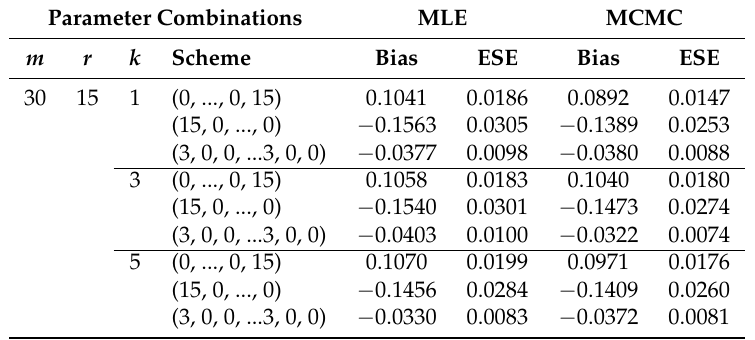
Table 7. The bias and ESEs of the MLEs and Bayes estimates of δ for ( α , β 1 , β 2 ) = ( 5,0.08,0.08 )